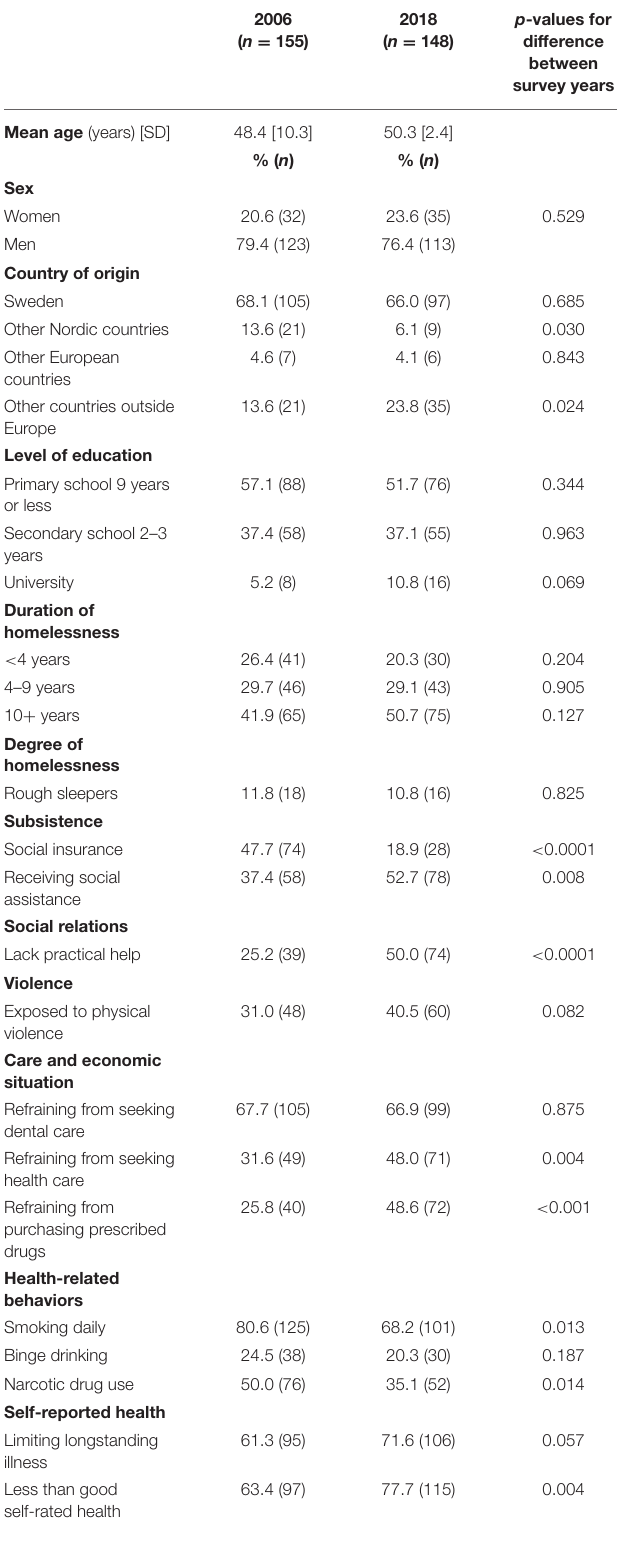
TABLE 1 | Demographic composition, certain social determinants of health, limiting longstanding illness, and less than good self-rated health among homeless people in 2006 and 2018, Stockholm.